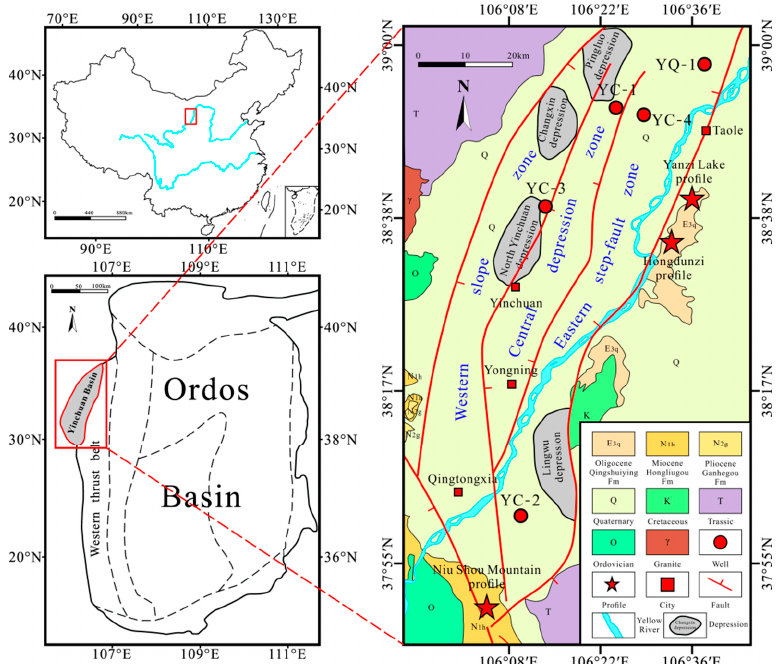
Figure 1. Geological structure map and section location map of Yinchuan Graben.